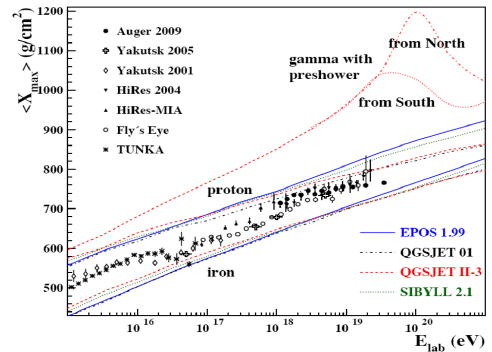
Figure 3. Dependence of X max on energy. Experimental data comparison with calculations for di ff erent hadron interaction models (proton, iron nuclei and high-energy gamma ray). Data obtained in 1973-1993 [17]